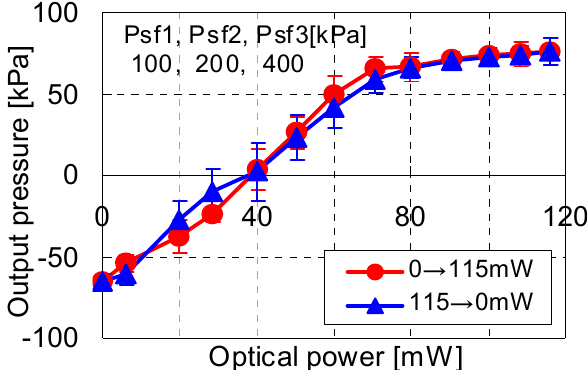
Fig. 6 Static characteristics of the photo-fluidic control valve